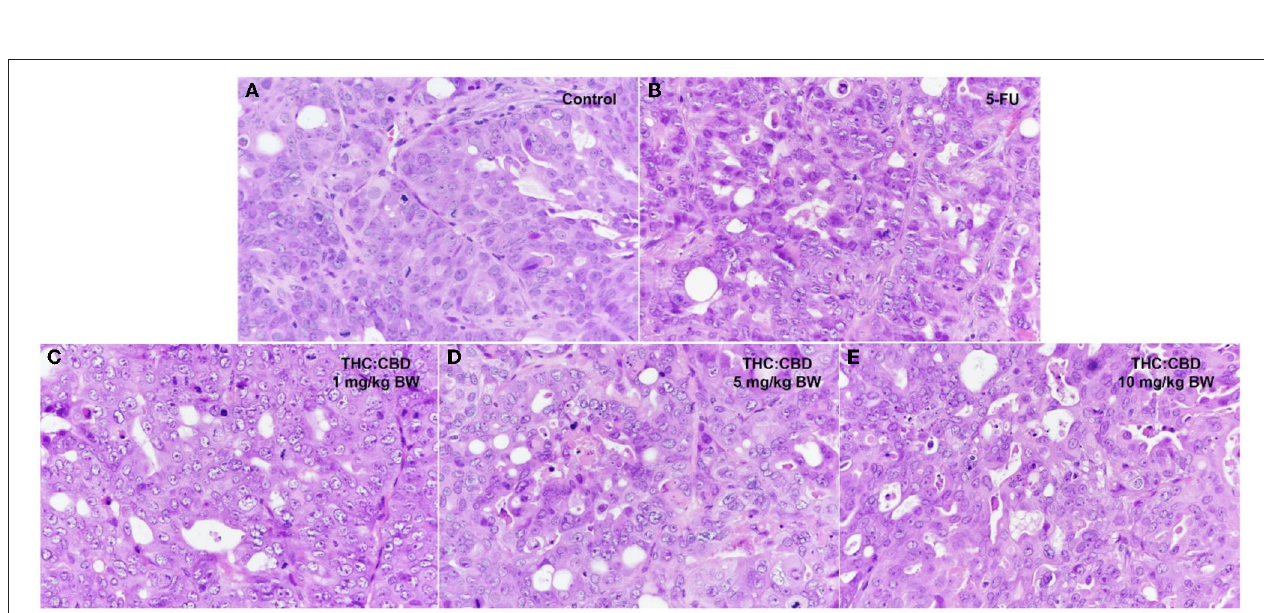
FIGURE 4 | Histopathological morphology of mice in the negative control group (A) , the positive control group (5-FU) (B) , and THC:CBD at dose of 1 mg/kg BW (C) , 5 mg/kg (D) , and 10 mg/kg (E) , (HE, 40 × ).